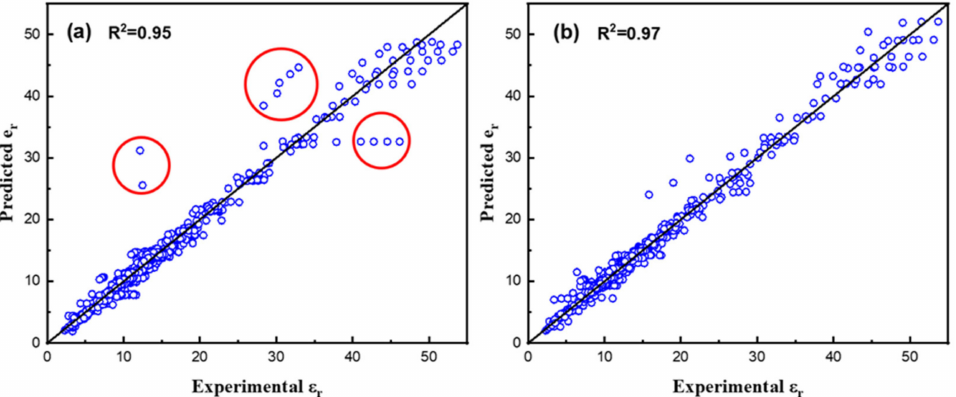
Figure 5. Dielectric constant prediction accuracy between ML prediction vs. experimental values from ( a ) original dataset and ( b ) modified